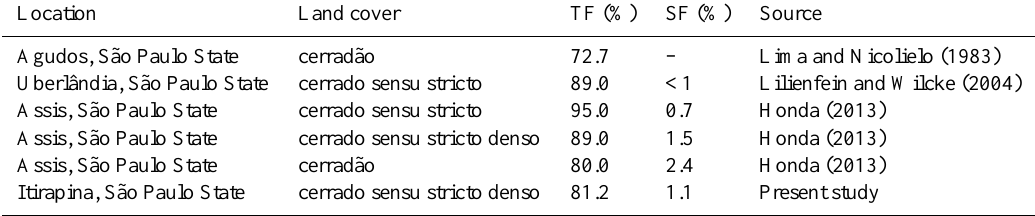
Table 4. Previous studies of throughfall (TF) and stemflow (SF) in the Brazilian cerrado. Percentages denote percent of total rainfall. Location Land